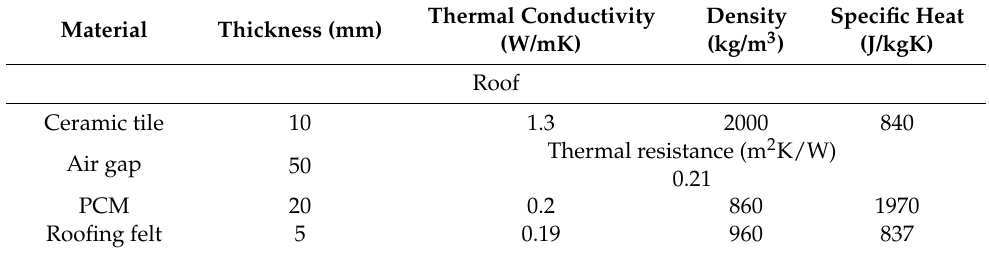
Table 2. Thermophysical properties of the roof composition.